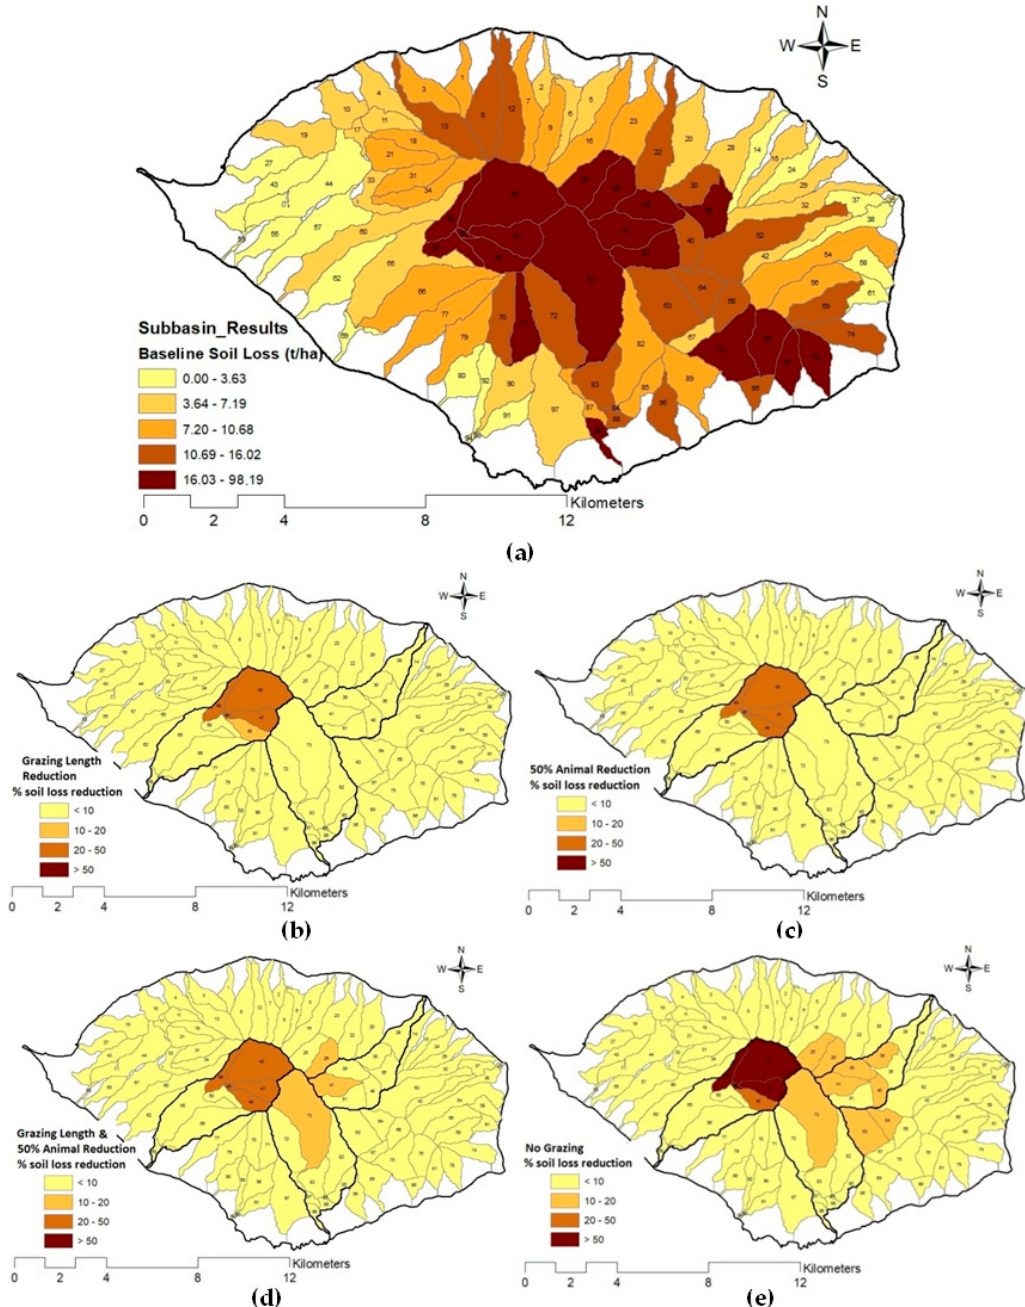
Figure 6. ( a ) Vulnerability of Samothraki’s subbasins to soil loss and percentage mean annual reduction of soil loss from the implementation of the four alternative management scenarios of Table 2: ( b ) grazing length reduction, ( c ) 50% animal reduction, ( d ) the combination of the previous two, ( e ) no grazing. The basins of Fonias, Xiropotamos, and Vatos are indicated (see also Figures 1 and 2a).